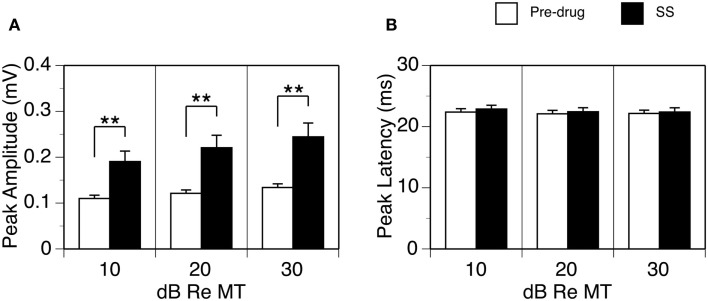
Group results (n = 26) showing effects of SS on the peak amplitude (A) and peak latency of the DN (B). For making (A,B), data from each animal were collected at the BF and 10, 20, and 30 dB above the MT of a recording sites. Double stars indicate statistical significance at the level of p < 0.001. Error bars represent SE.